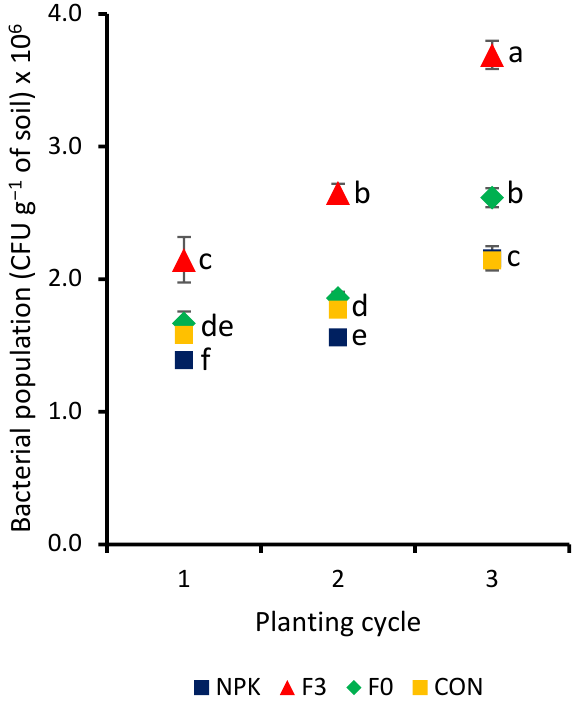
Figure 7. Means ( ± SE) of interaction between the treatments and planting cycles on bacterial population across soil types. Means with the same letter are not significantly different ( p > 0.05) from one another using Tukey’s test.